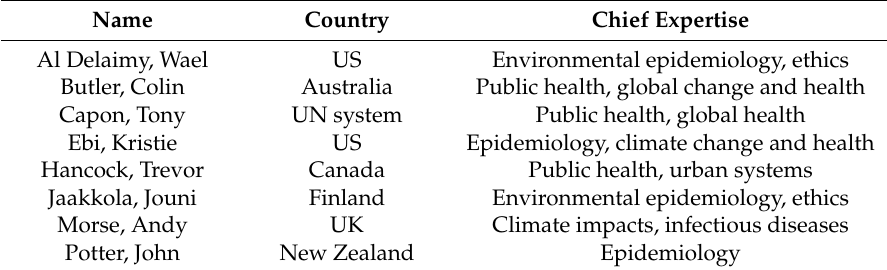
Table 3. In 2014, eight individuals associated with interdisciplinary research groups, all with strong links to health, established the network Health-Earth (H-Earth) from six countries and one UN University eight co-founders of Health-Earth. Prof Colin Soskolne, not a co-founder, is an affiliate at the University of Canberra,